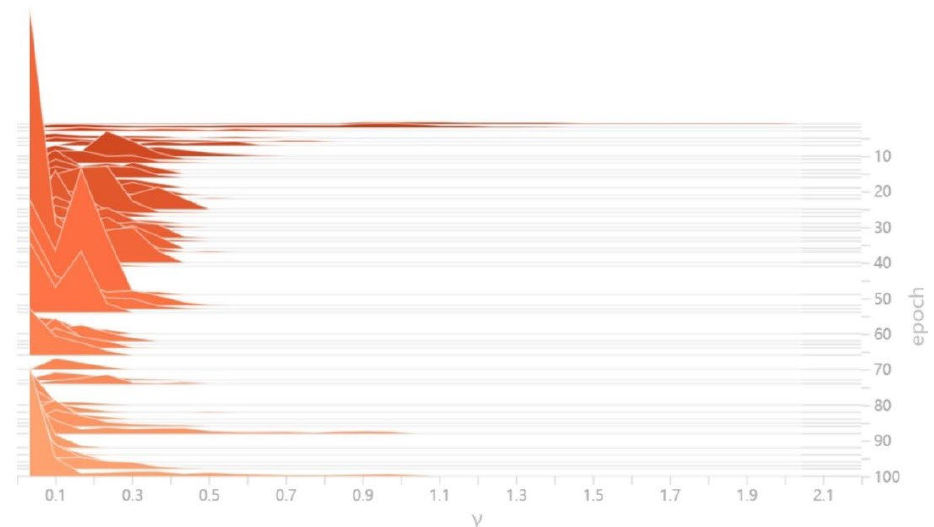
Figure 9. Distribution of BN layer scaling factor γ before sparse training.